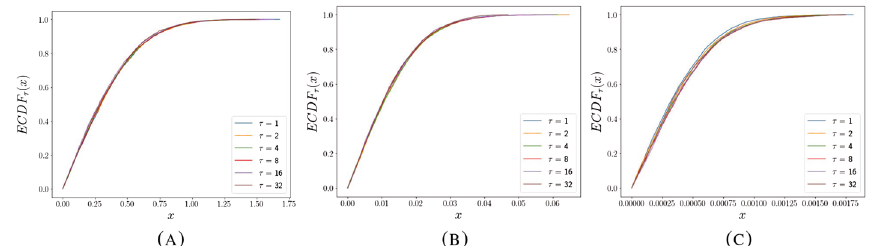
Fig. 1 Empirical cumulative distribution function of the samples of the GHE(1) method from fractional Brownian motions, with size 2 12 and Hurst exponent A 0.1, B 0.5, and C